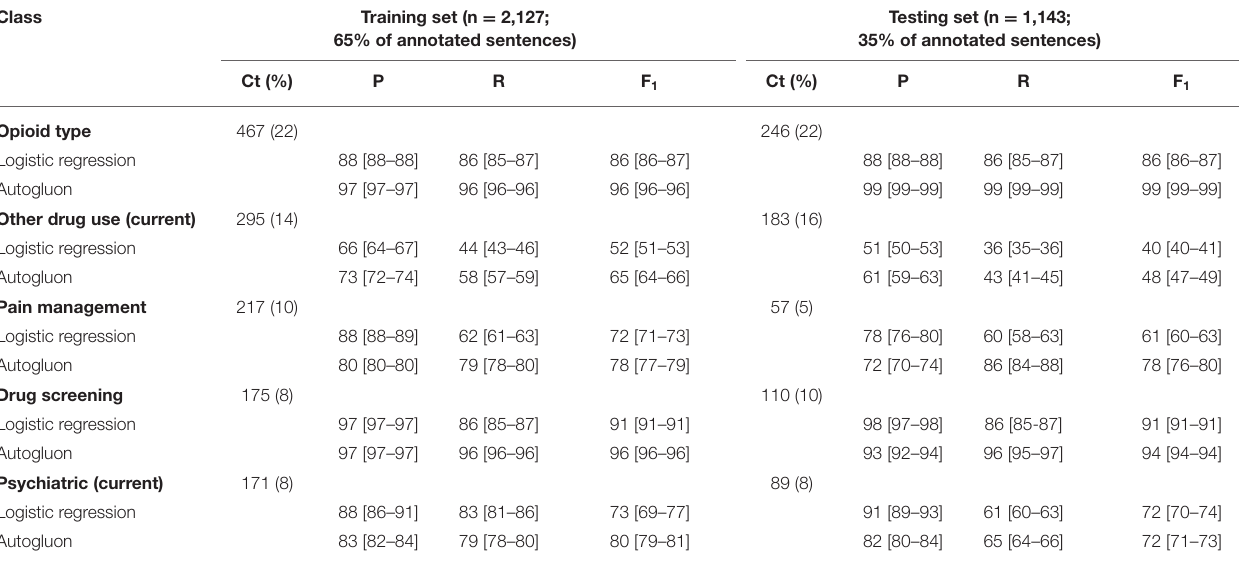
TABLE 3 | Performance metrics (means and 95% confidence intervals) for each class with ≥ 100 annotation instances. Class Training set (n = 2,127; 65% of annotated sentences)